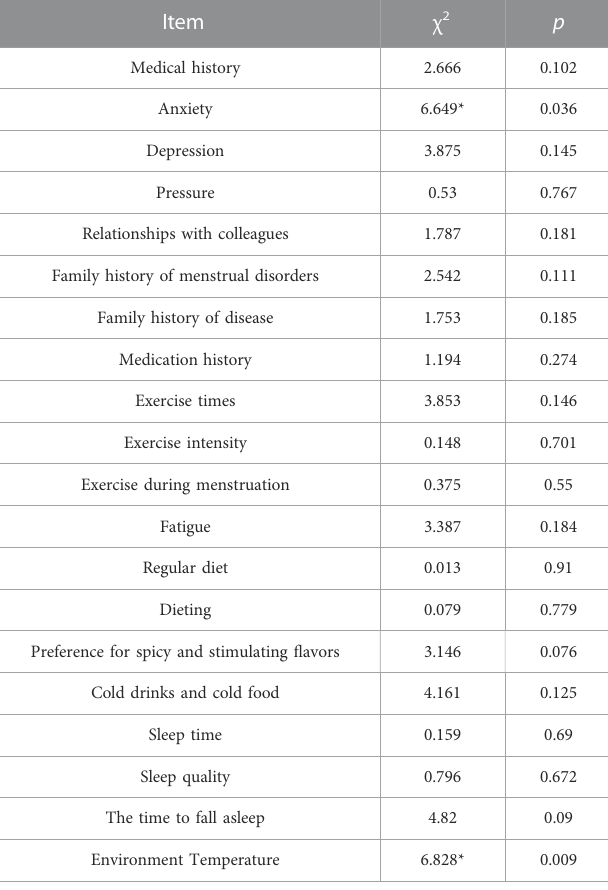
TABLE 2 Correlation variables of the two